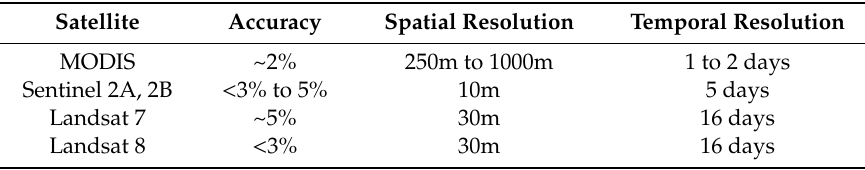
Table 2. Sensor characteristics and accuracy